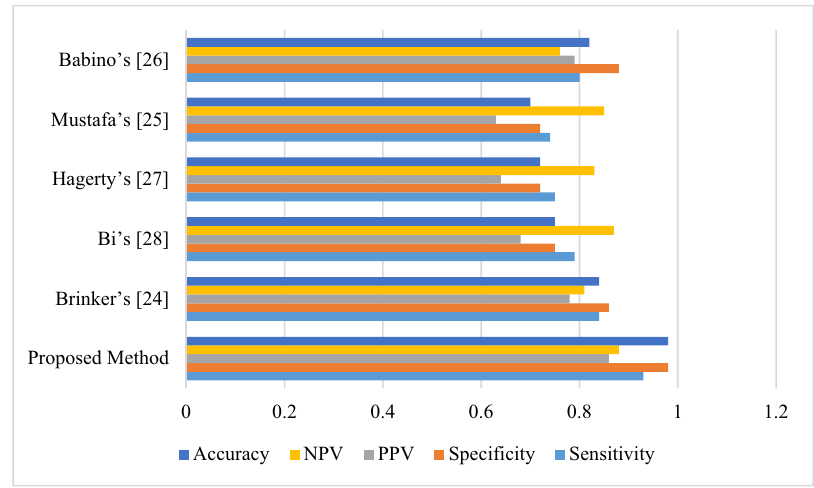
Figure 4: The classi fi cation analysis of the proposed method toward some other state of the art